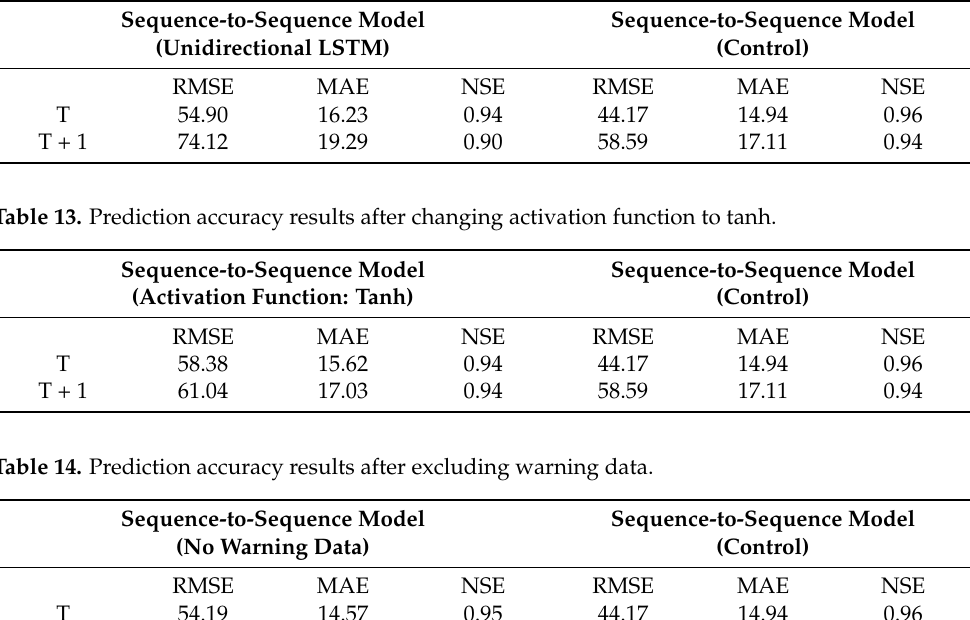
Table 12. Prediction accuracy results after removing bidirectionality from LSTM.